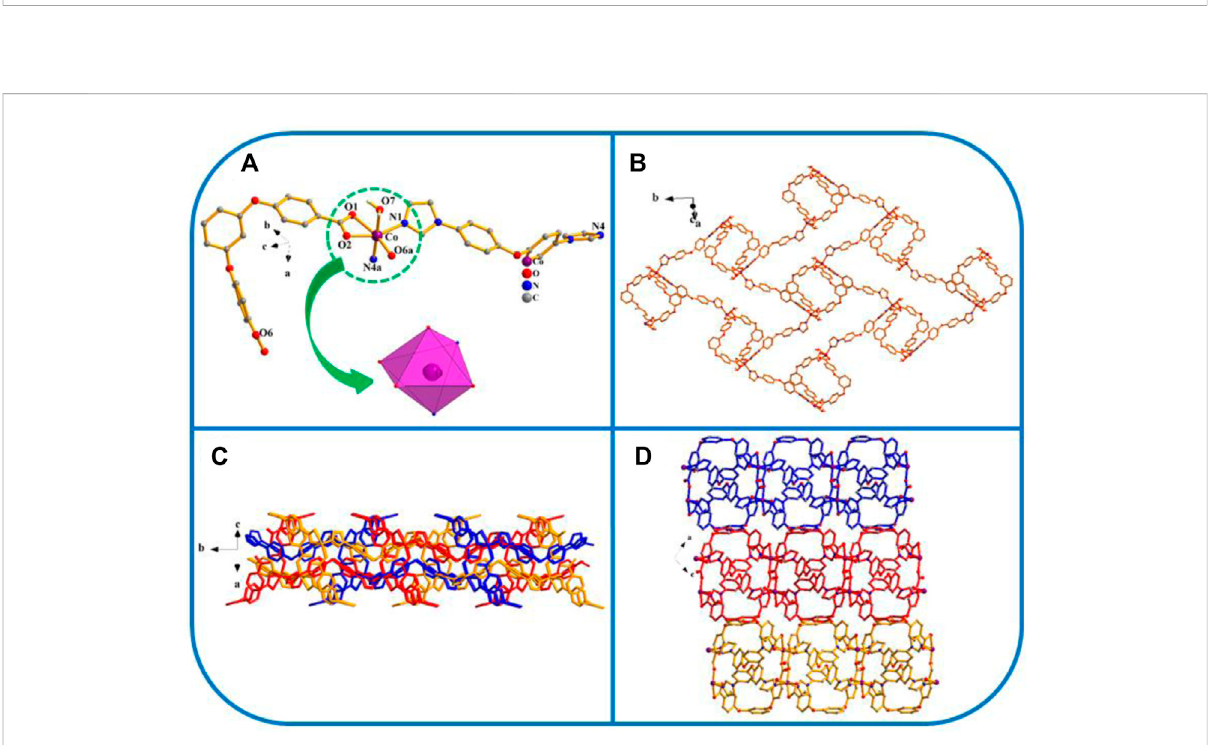
FIGURE 5 (A) CoordinationunitoftheCoioninYMUN5((hydrogenatomsareomittedforclarity),symmetrycodes:(i)- x +1,- y ,- z +1;(ii) x -1/2,- y +3/2, z -1/ 2;(iii) x +1/2,- y +3/2, z +1/2.); (B) viewofthesingle2Dlamellarstructureof5; (C) viewofthethree-foldinterpenetrating2Dstrati fi ednetworkthrough theidentical2Dlamellarstructuresof5; (D) viewofthe3Dframeworkthroughthe2Dstrati fi ednetworkwithweakinteractionsoccurringalongthe b